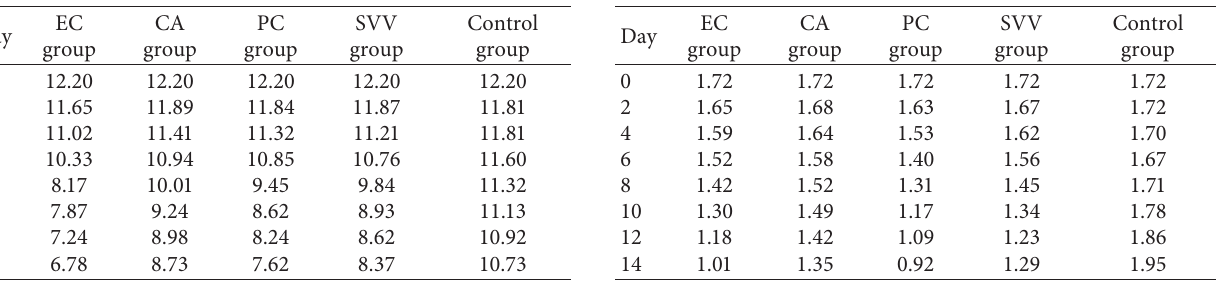
Figure 1: Changes of total nitrogen content in wastewater treated by plants. Table 2: Data table of changes in total nitrogen content of Table 3: The change data table of the total content of each plant wastewater treated by plants. treated